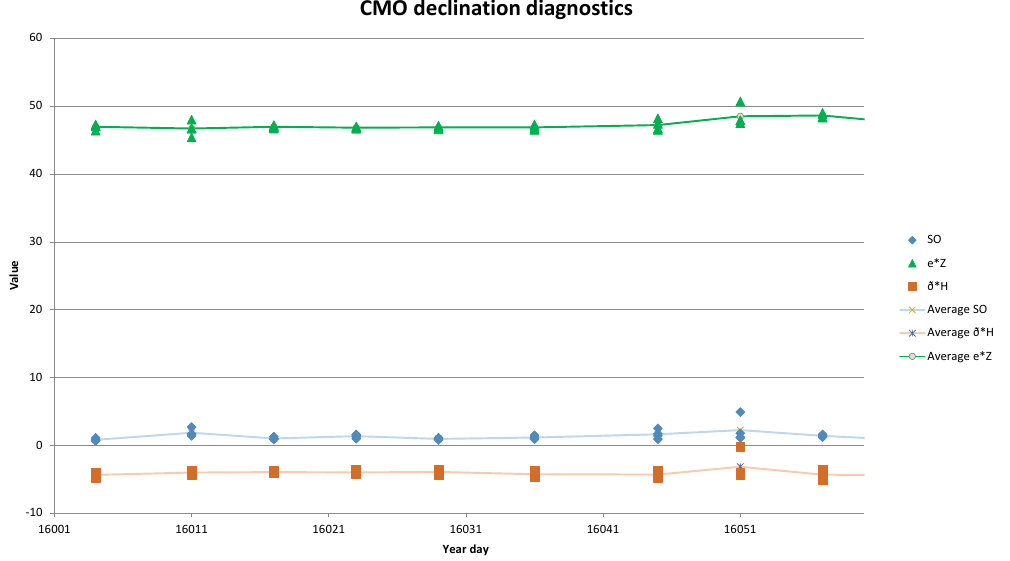
Figure 2. Declination diagnostic parameters from absolute observations for the first 2 months of 2016, plotted with an arbitrary vertical scale. The graph shows the four individual observations and their average. There is an outlier value observed on day 51 that is probably a bad measurement that should be eliminated before